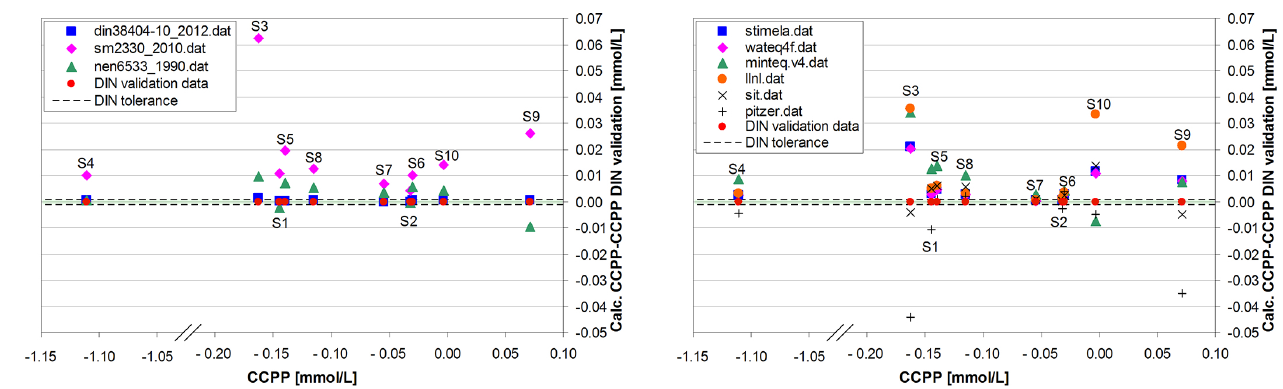
Figure 4. Deviations of the CCPPs calculated in PHREEQC ac- cording to the DIN, SM and NEN standards, from the CCPPs given in the DIN validation data set for the 10 water quality samples S1 to S10 (see Table 5).